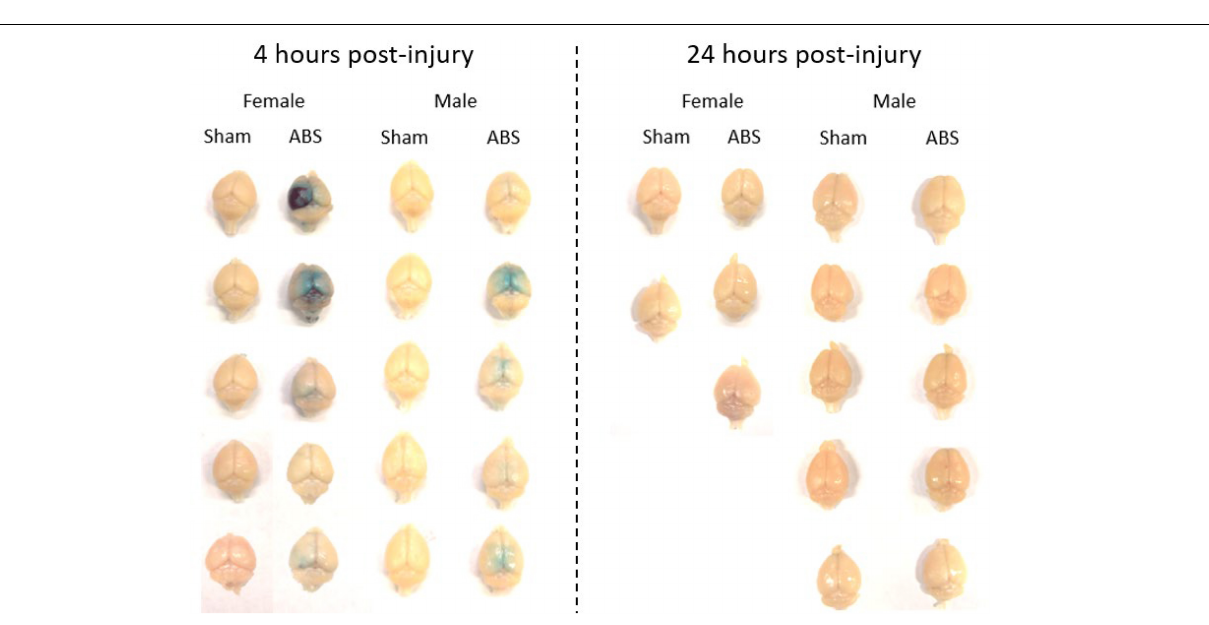
FIGURE 6 | Evans blue was evident 4 but not 24 h after shock wave exposure. Evans blue staining was present on the brain parenchyma of ABS-exposed male and female mice 4 h after injury, but was not apparent on the brains of sham animals. One day after shock wave exposure, Evans blue was not observed on the brain parenchyma of either ABS-injured male and female or sham